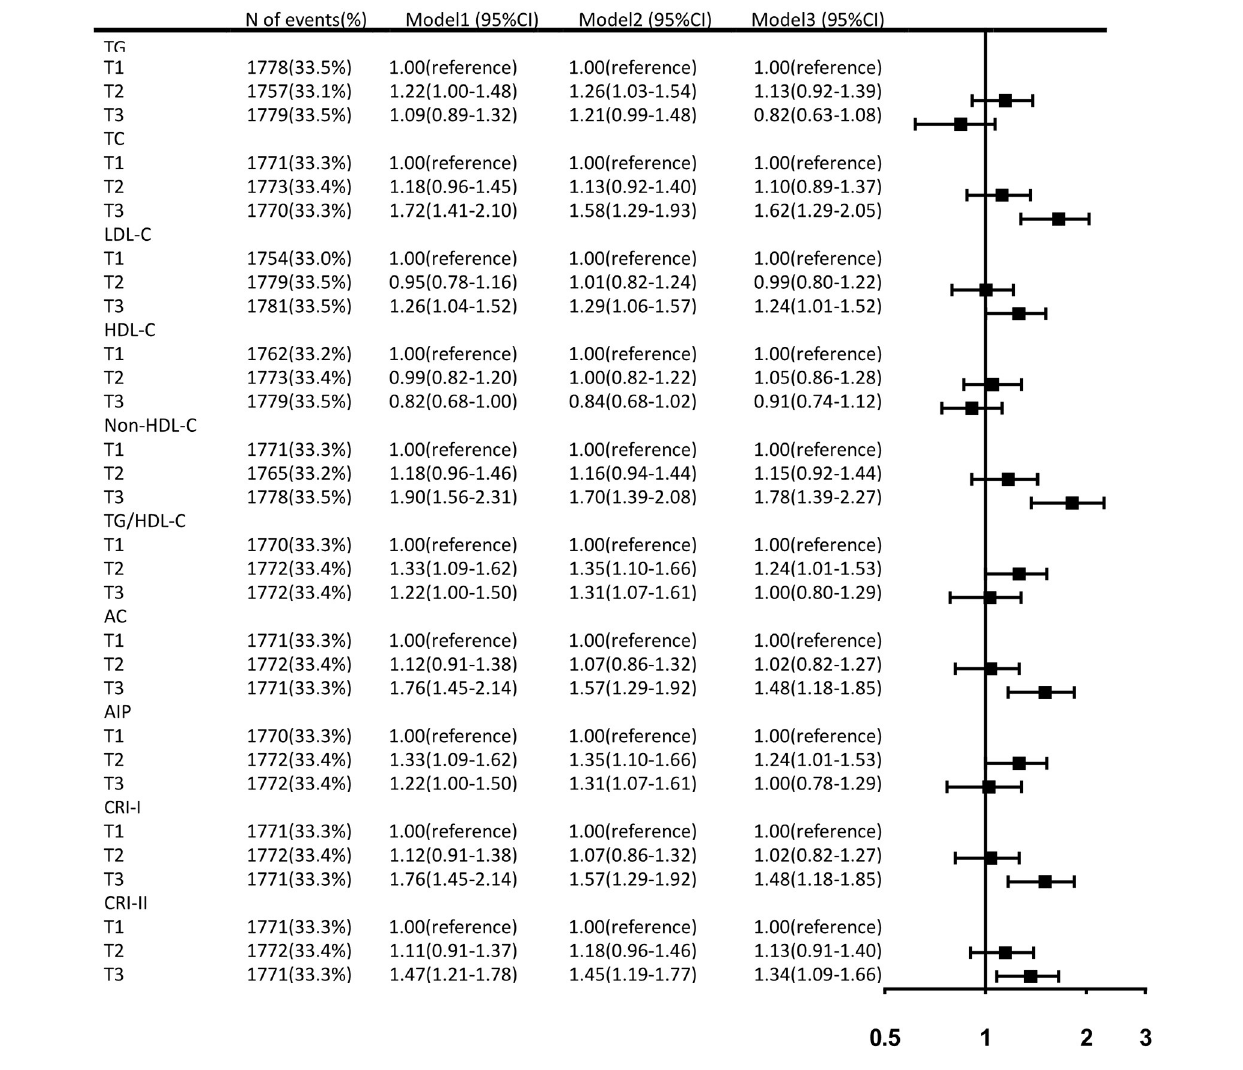
FIGURE 1 | Fully adjusted ORs and 95% CIs of lipid parameters for the prevalence of aICAS. Data were adjusted for age, gender, BMI, education, income, physical activity, smoking status, drinking status, history of hypertension, diabetes, dyslipidemia, antihypertensive agents, and antidiabetic